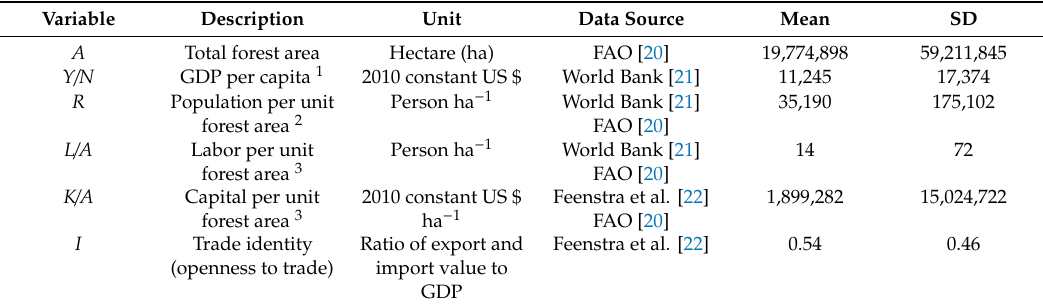
Table 1. Description of variables used in estimating the Environmental Kuznets Curve (EKC) model of global total forest area and their summary statistics. The total number of countries was 117, giving 585 total observations, with Africa (45), Asia (26), Europe (21), North America (14), South America (10) and Oceania (2). Data time periods were 1990, 2000, 2005, 2010, and 2015. FAO: the Food and Agriculture Organization, GDP: gross domestic